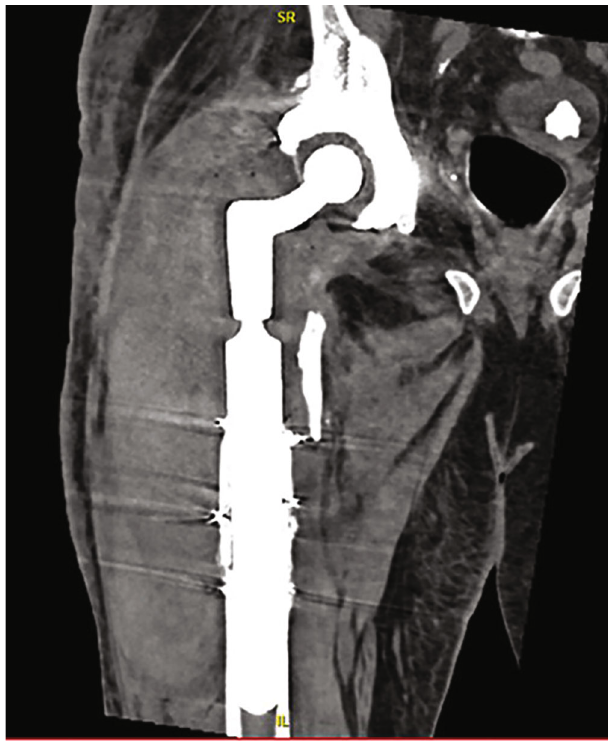
Figure 5: Computedtomographyscanforrightthighswelling,revealing a 11.5cm anteroposterior × 11cm mediolateral × 33cmcraniocaudal